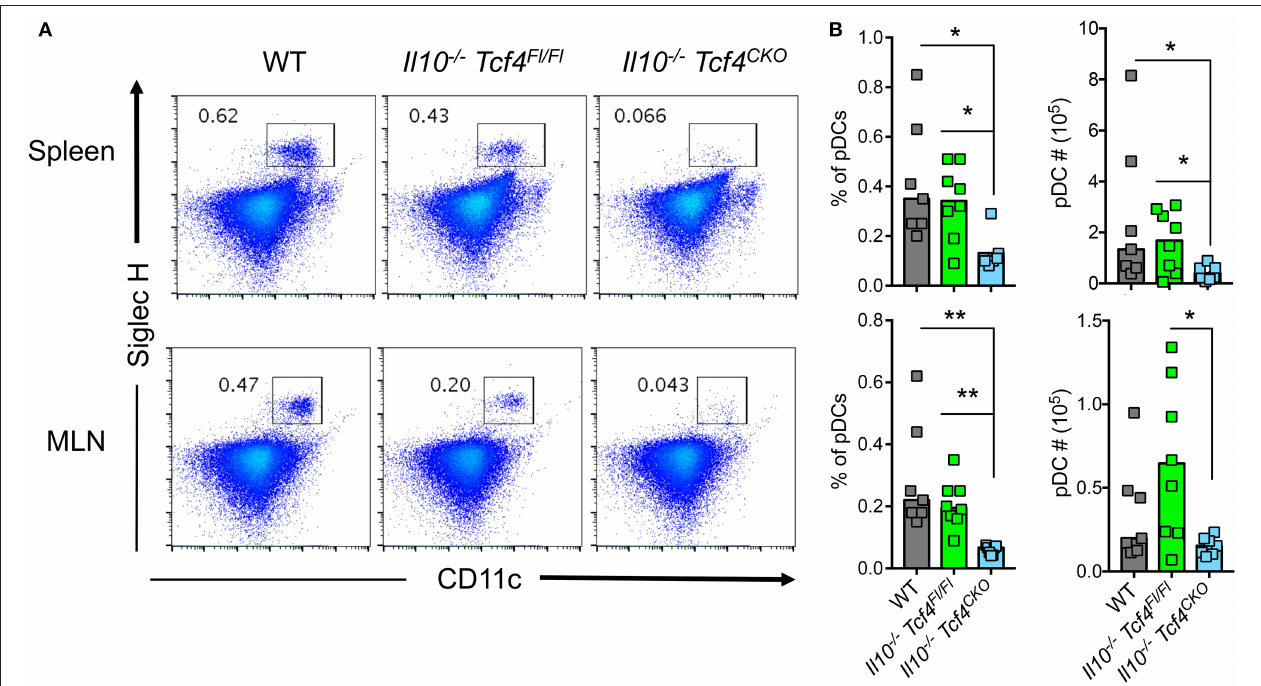
FIGURE 5 | DC-specific deletion of Tcf4 significantly depletes pDCs in Il10 -deficient mice. Il10 − / − Itgax -Cre − Tcf4 flox / flox ( Il10 − / − Tcf4 Fl / Fl ) or Il10 − / − Itgax -Cre + Tcf4 flox / flox ( Il10 − / − Tcf4 CKO ) littermates with DC-specific Tcf4 CKO were analyzed along WT controls at 15 weeks of age. (A,B) pDCs were analyzed by flow cytometry of cells from the spleen and MLN. The frequency of CD11b − CD11c + Siglec H + pDCs is indicated in each plot. (B) Frequency and absolute numbers of CD11b − CD11c + Siglec H + pDCs among total live cells in the spleen and MLN of individual animals are shown, and horizontal bars indicate the median. Data represent 3 independent experiments. Statistical significance estimated by Kruskal-Wallis test followed by a post-hoc Dunn’s multiple comparison test is indicated as follows * P ≤ 0.05, ** P ≤